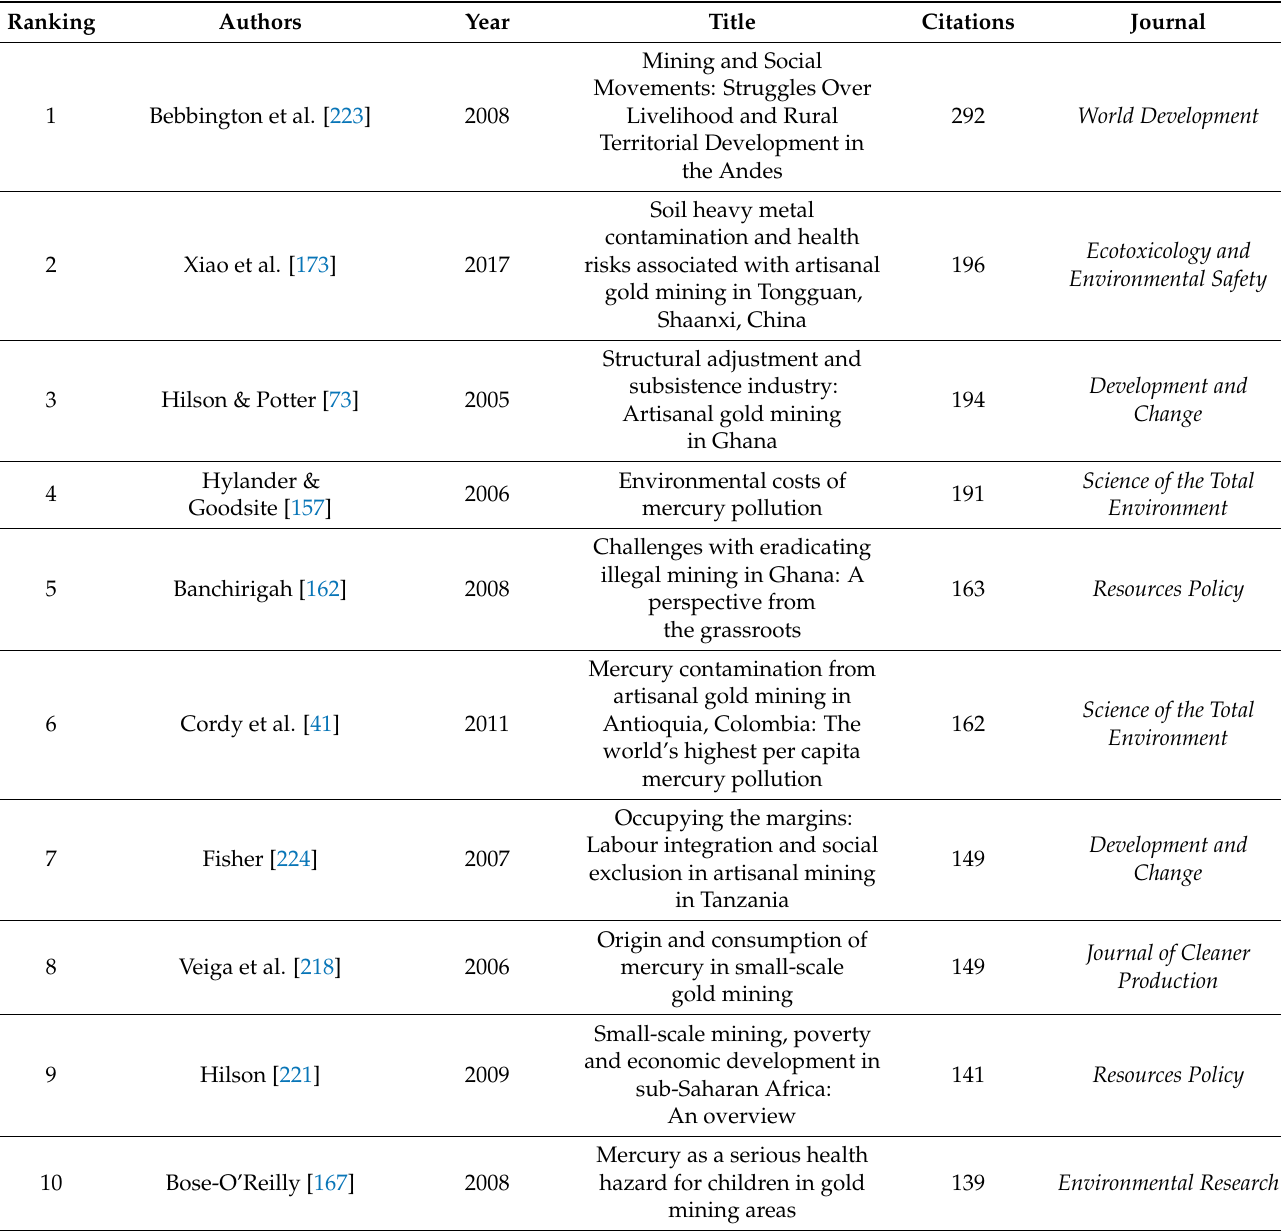
Table 3. Top 10 most cited